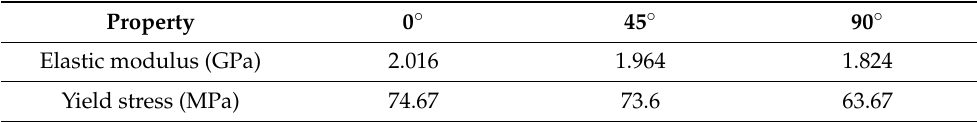
Table 2. Elastic mechanical properties of cylindrical specimens made from poly-lactic acid (PLA)